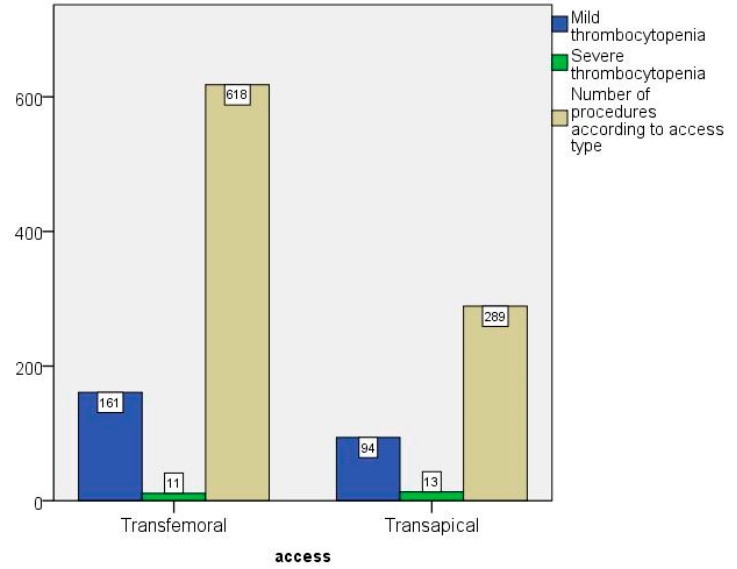
Figure 2. Incidence of mild (MT) and severe (ST) thrombocytopenia according to transfemoral (TF) or transapical (TA) access.